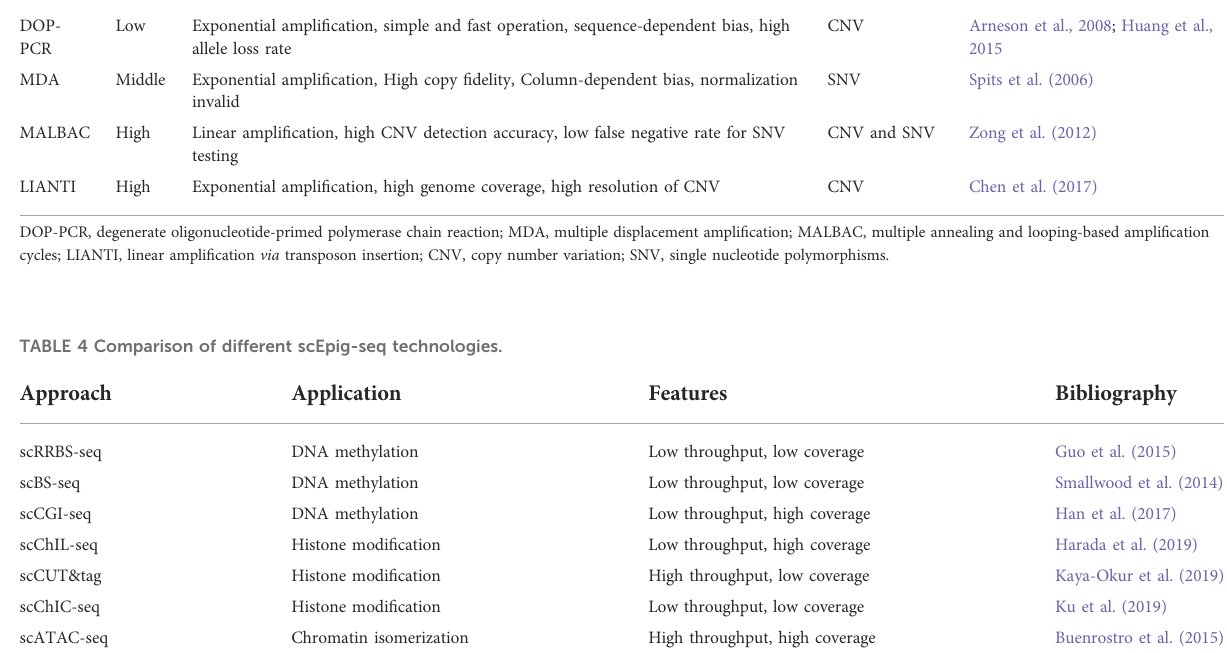
scATAC-seq Chromatin